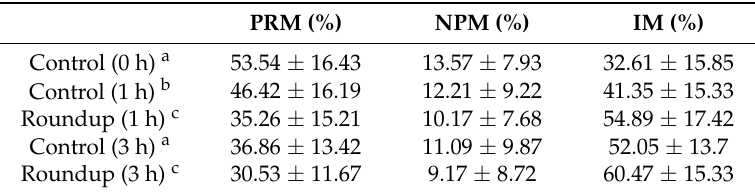
Table 2. Percentage of sperm motility in untreated (control) and Roundup-treated 66 semen samples at 0, 1, and 3 h post-incubation.